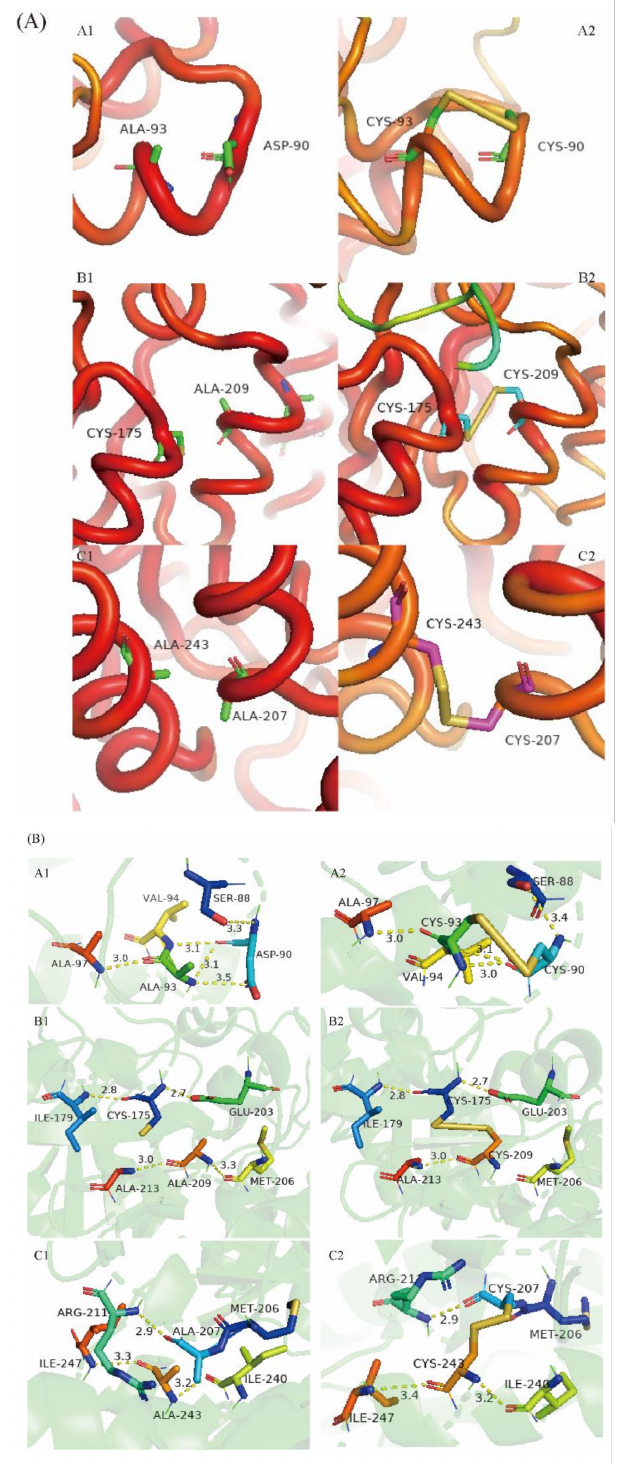
Figure 6. ( A ) 3D Local structures around residues D90/A93 (A1), C175/A209 (B1), and A207/A243 (C1) in wild-type DPEase, with the disulfide bridges in the mutants D90C − A93C (A2), C175 − A209C (B2), and A207C − A243C (C2) superimposed. The relative B-factors are shown by color coding; B-factor values are represented by blue, green, yellow, and red in ascending order. ( B ) Local models of 3D structures around residues D90/A93 (A1), C175/A209 (B1) and A207/A243 (C1) residues in wild-type DPEase and the cysteine-substituted mutants D90C − A93C (A2), C175 − A209C (B2) and A207C − A243C